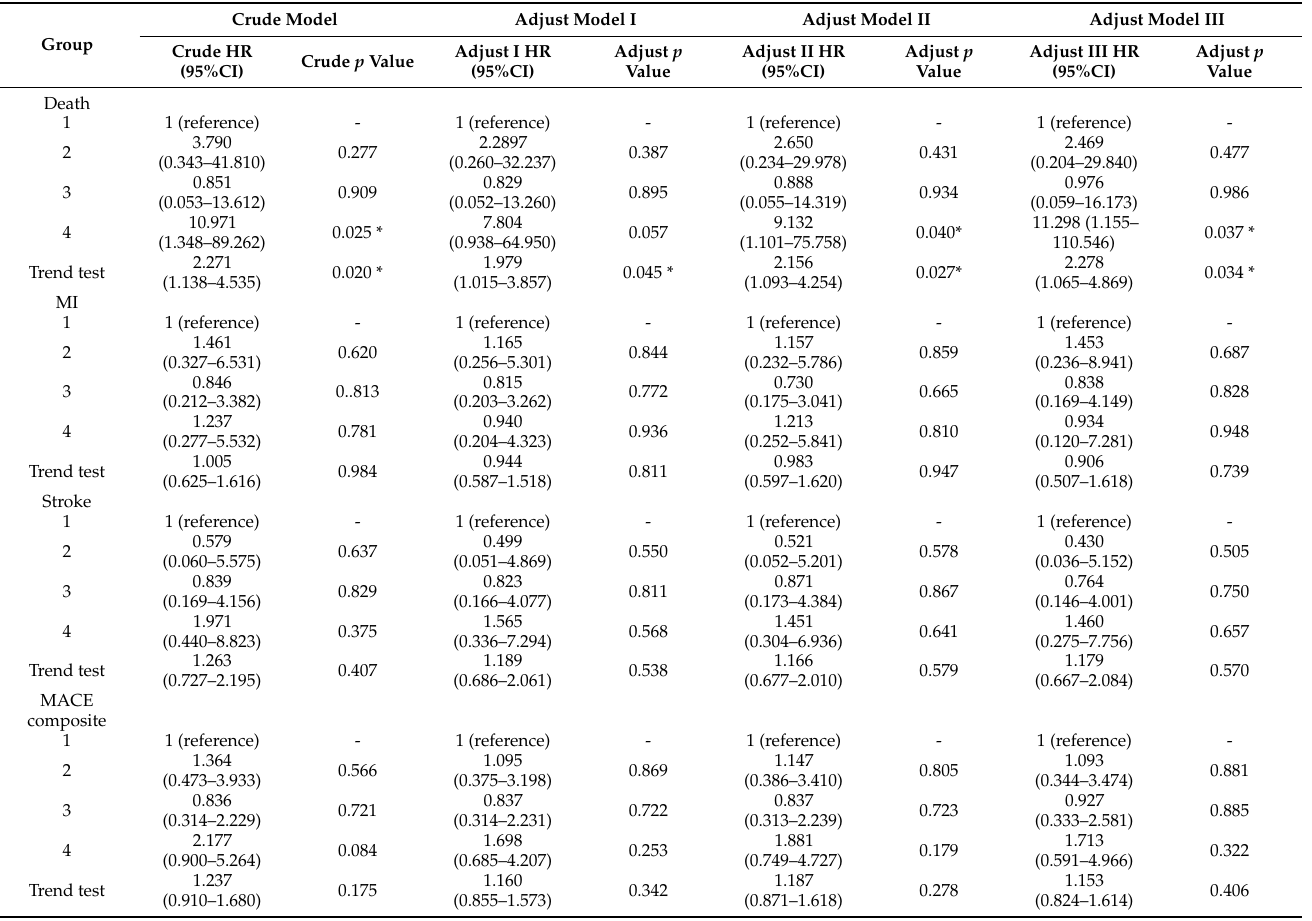
Table 2. Association between separate endpoints survival and groups which divided by plaque types and peak NT-proBNP in all enrolled